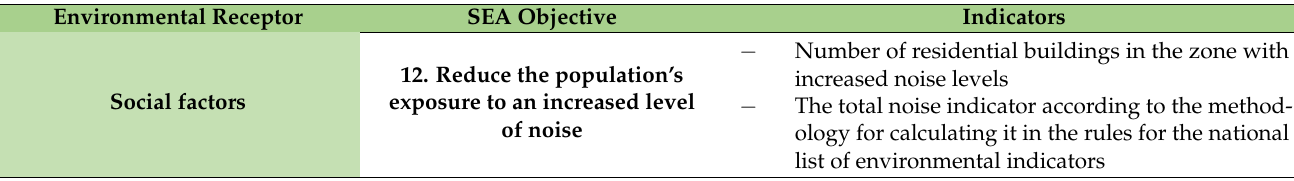
Table 1. Excerpt from the table “SEA objectives and indicators” related to noise. (Source: SEA for the Urban Plan of the Maestrale Ring wind farm).